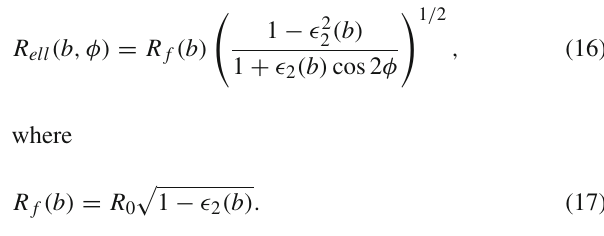
Fig. 7 Variation of total charged particle multiplicity ( n ch ) for tip–tip and body–body configuration of U + U collisions